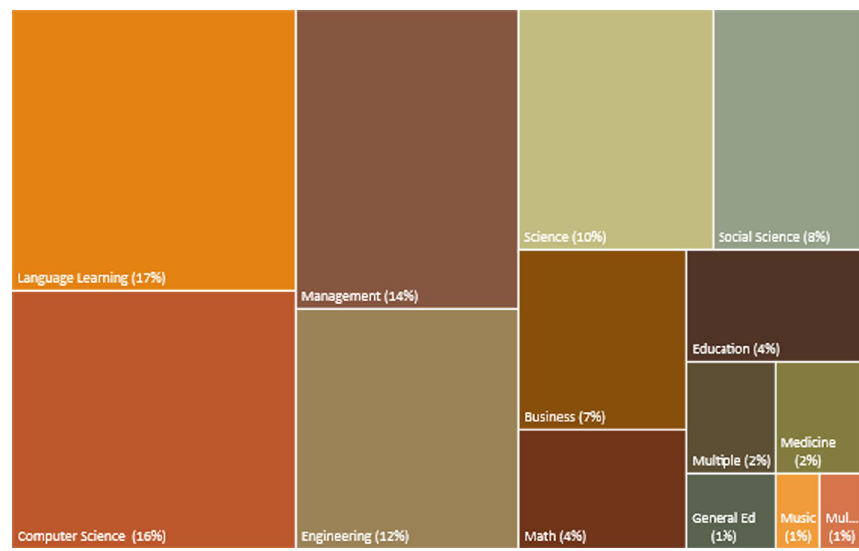
Fig. 6 Subject domains of AIEd in